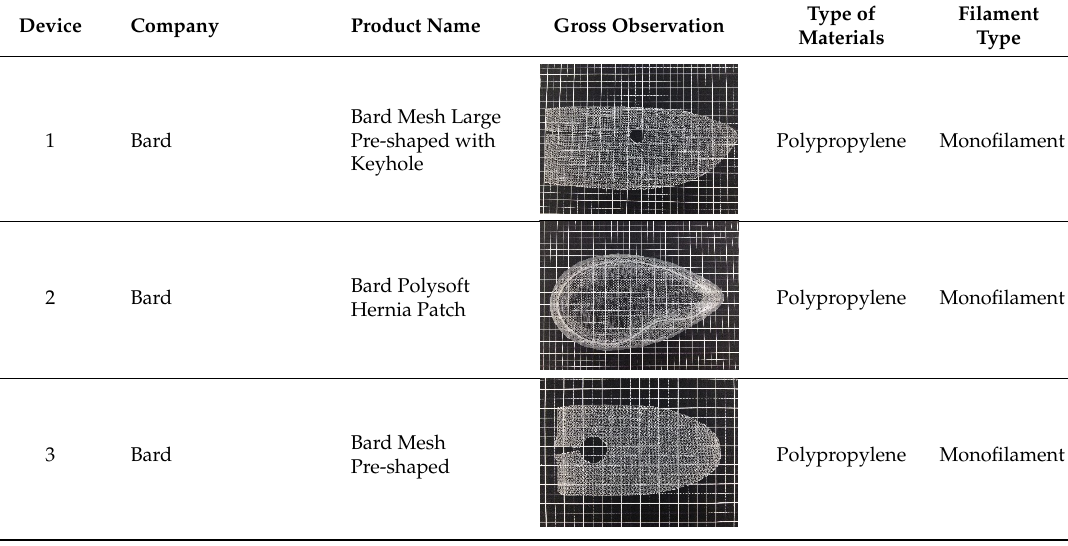
Table 5. Hernia prostheses selected.